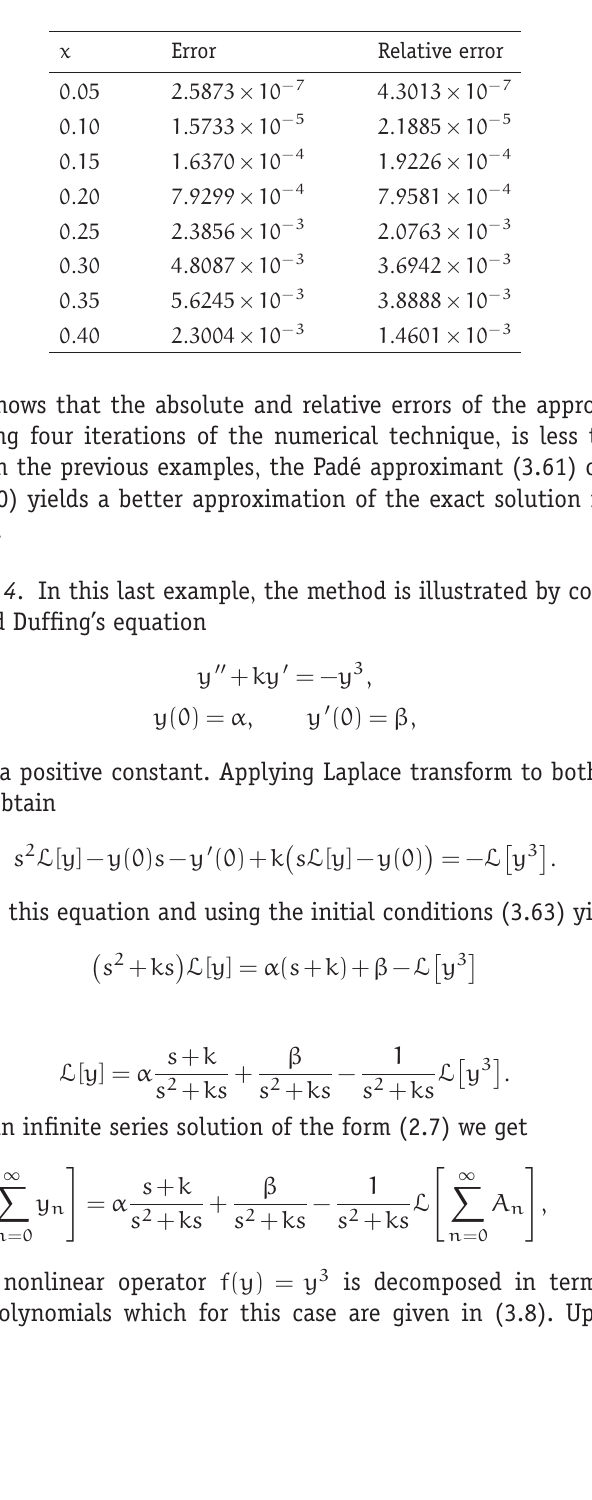
Table 3.4. Error obtained using four iterations of the numerical